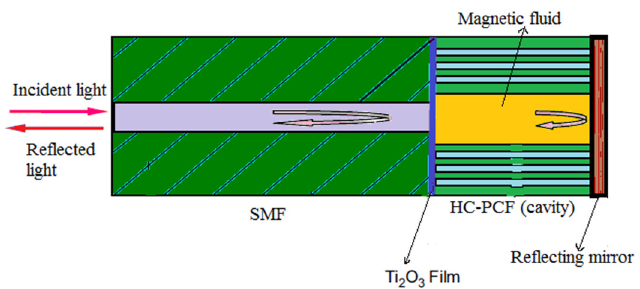
Figure 31. Schematic diagram of magnetic fluid filled hollow core PCF Fabry-Perot cavity sensor (Reproduced from [98], with the permission of Elsevier publishing).